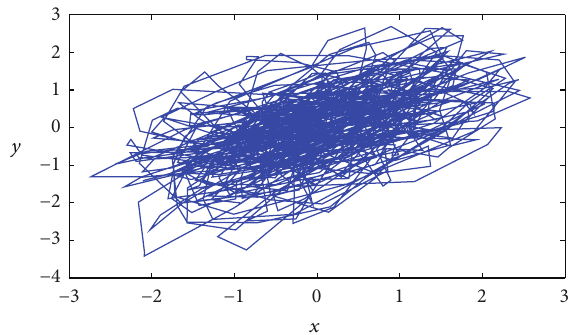
Figure 1: Example of the posturographic signal after 2.6 Hz high- passfiltering.Thelowfrequencyandlarge-amplitudeoscillationsare removed uncovering the relation between 𝑥 𝑛 and 𝑦 𝑛 components. After the PCA rotation, the first column 𝑆 1 represents the long diagonal of the path area and the second column ( 𝑆 2 ) represents the short diagonal.